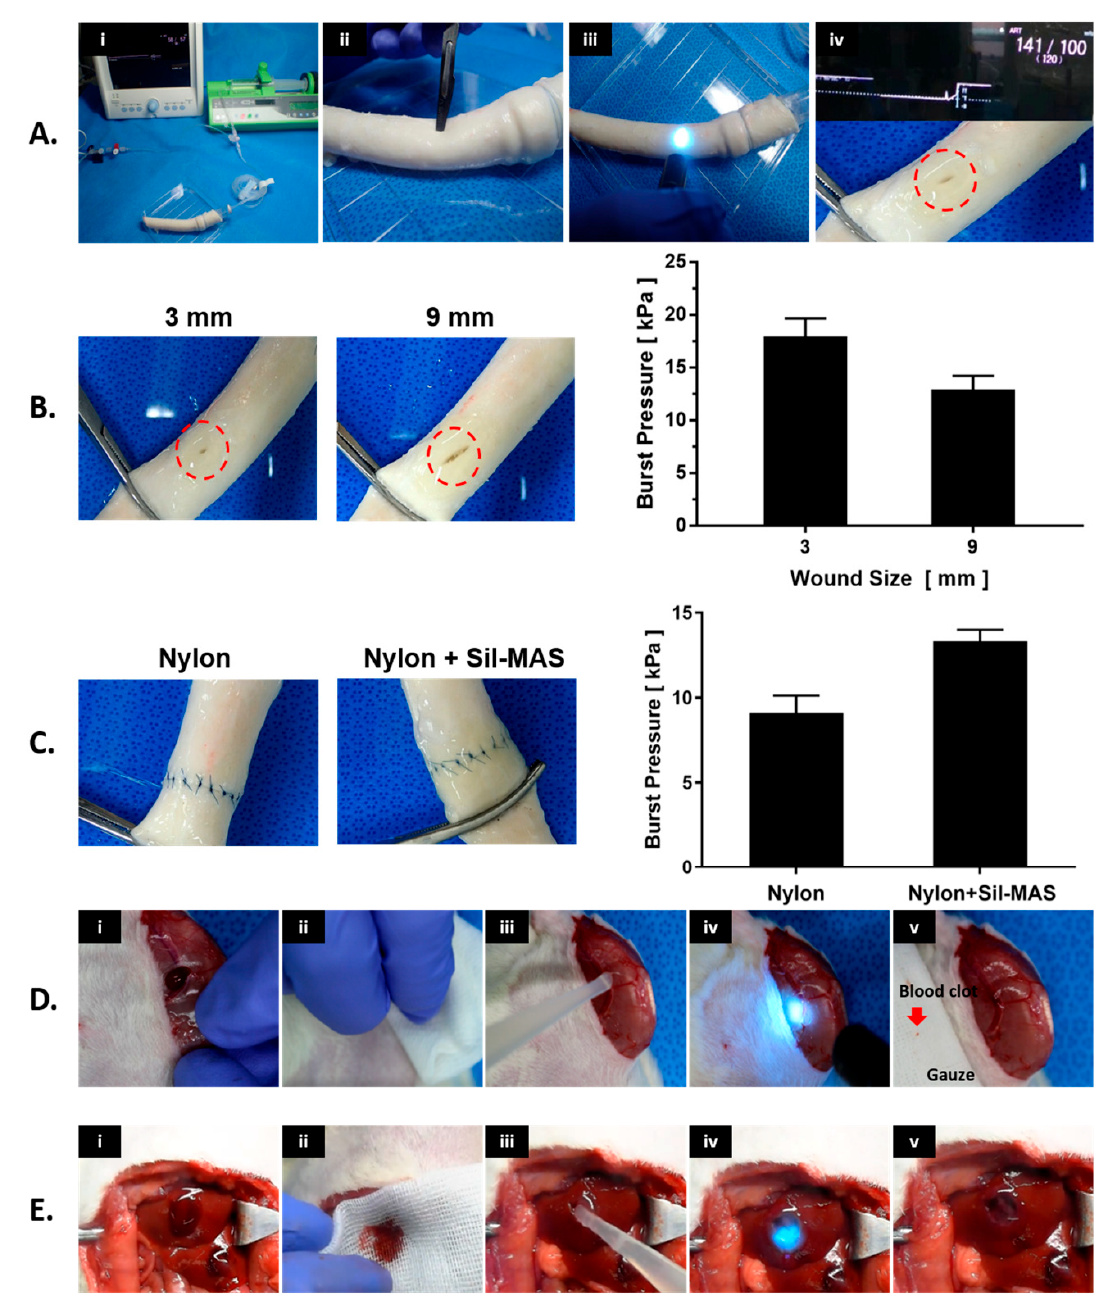
Figure 6. Vascular adhesive and hemostatic effect of Sil-MAS on wet surfaces. ( A ) Images of ex vivo burst pressure test process for Sil-MAS. ( i ) The setup for the burst pressure experiment, ( ii ) Opening in the middle of the aorta, ( iii , iv ) Appication of Sil-MAS on the wound site and UV exposure. ( B ) Porcine aorta burst pressures on the incision shielded with Sil-MAS. ( C ) Porcine aorta burst pressures after end-to-end anastomosis by Nylon suture alone and Nylon suture with Sil-MAS. ( D ) In vivo vascular closure experiment of Sil-MAS. ( i ) Femoral artery incision and bleeding, ( ii ) Slight hemostasis using gauze, ( iii ) Use of Sil-MAS on the incision site and UV exposure, ( iv ) Cessation of bleeding, ( v ) Confirmation of hemostasis. ( E ) Images of the sealants used in an in vivo liver parenchymal injury model. ( i ) The bleeding from the injury site rose after a circular tissue extraction with a 0.5 cm long and 0.5 cm deep wound on the rat liver surface. ( ii ) After wiping the wound using gauze for slight hemostat, ( iii ) Sil-MAS (or Fibrin glue) was employed to the resected site, ( iv ) cross-linked by UV (for Sil-MAS) and thrombin (for Fibrin glue), and ( v ) bleeding stopped. [84].